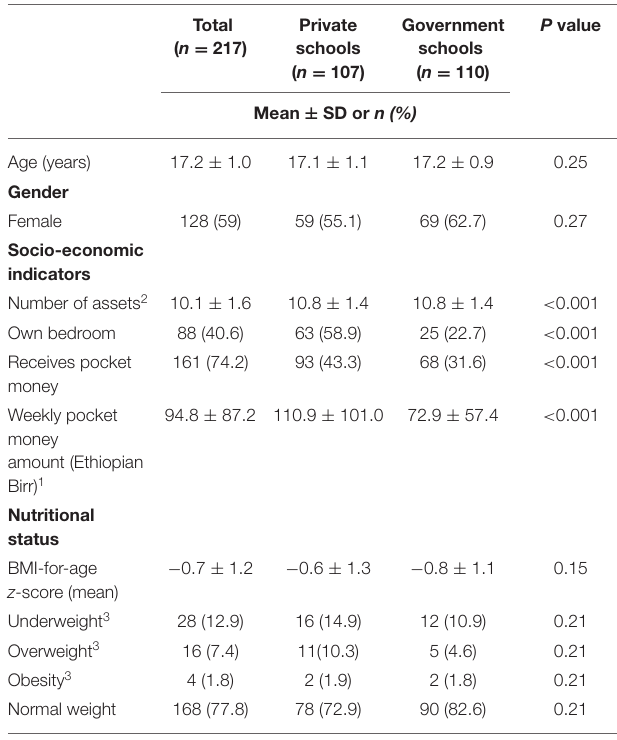
TABLE 1 | Socio-demographic and anthropometric characteristics of study participants (total and separated by school